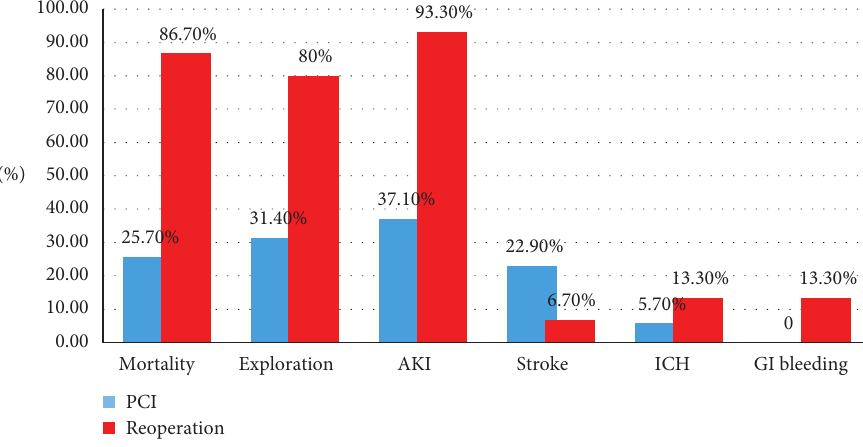
Figure 4: Hospital outcomes of the PCI and reoperation Table 6: Predictors of hospital mortality.